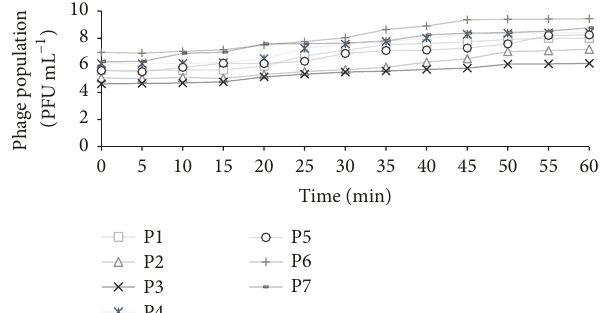
Figure 7: Experimental one-step growth curves of phages over a period of 60 min.